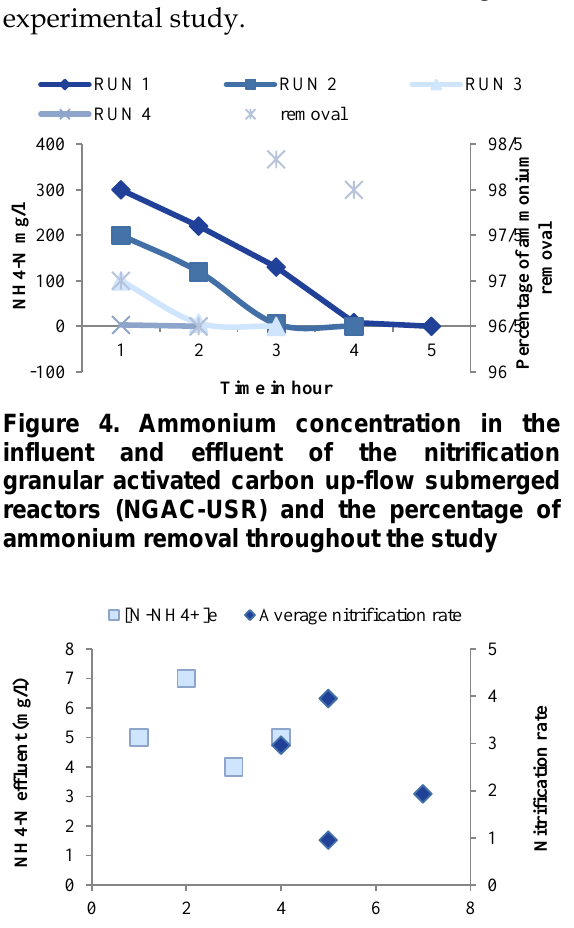
Figure 5. Effect of applied nitrification rate on